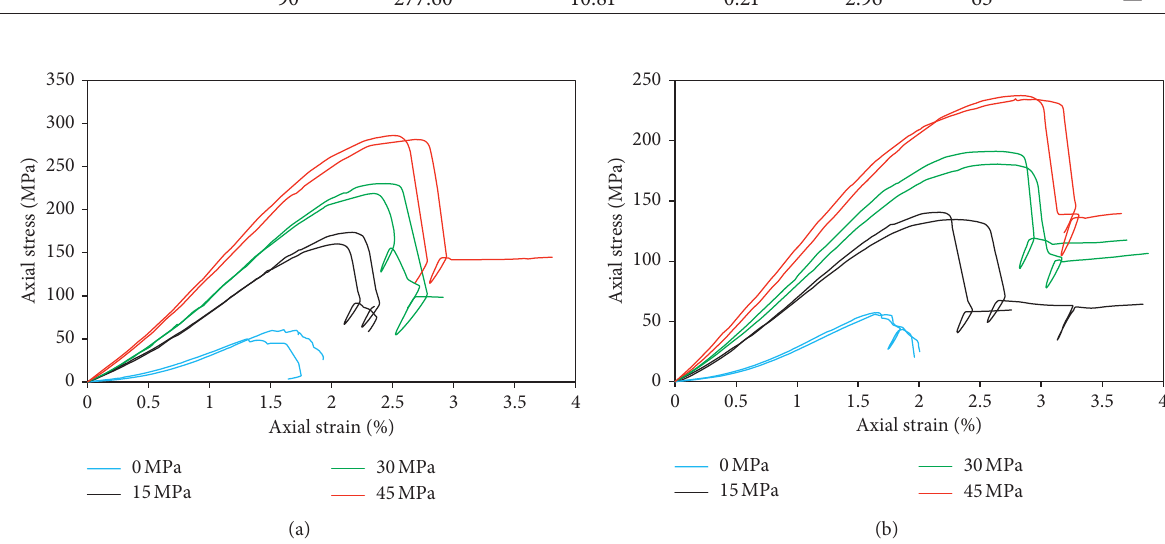
Figure 3: Typical curves of stress-strain of tight sandstone samples with the same dip angle under different confining pressure. (a) Angle α � 0 ° . (b) Angle α � 60 °